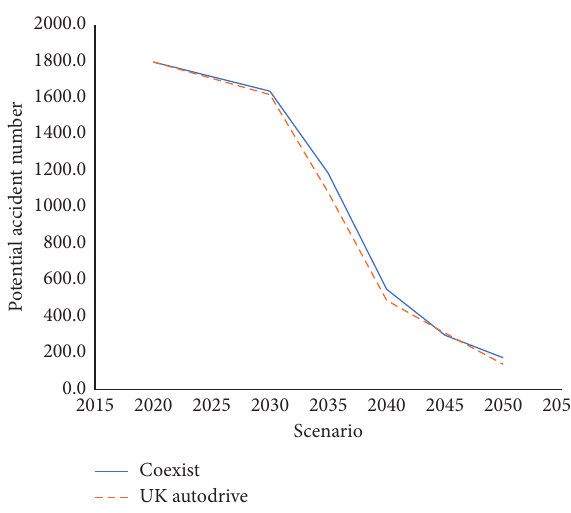
Figure 7: PAN comparison for two projects at the Sattarkhan intersection. Table 7: The sensitivity analysis of potential accident number for each demand scenario compared to the real-world scenario at the Vesal intersection.